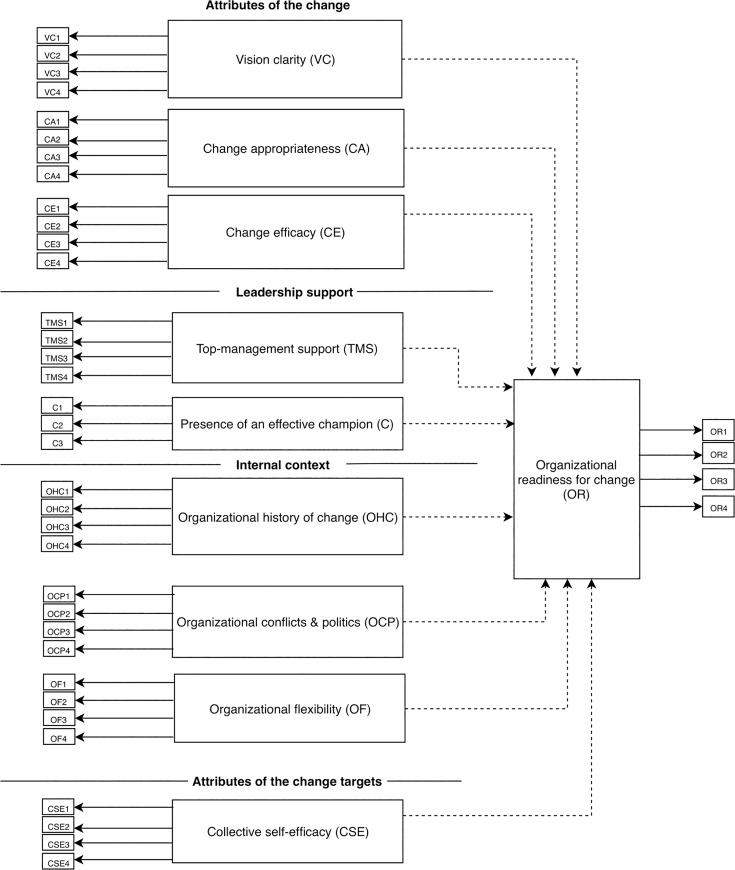
Research model.Solid arrows show paths from indicator variables (questionnaire item) to the latent variables. Dashed arrows show paths from exogenous latent variable to the endogenous latent variable. See Paré et al. [24] for definitions of the constructs.